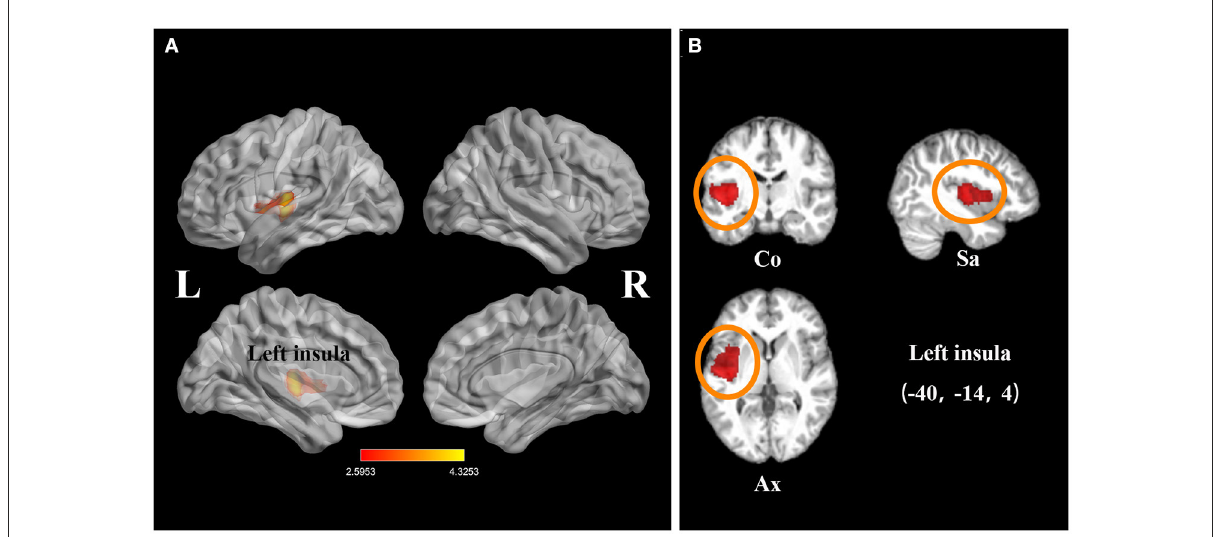
FIGURE4 Statistical parametric maps showing the decreased gray matter volumes in patients with spinal cord injury (SCI; time since injury > 1 year) compared with those of healthy controls in the subgroup meta-analysis. (A) The overlay of statistical parametric maps showing the decreased gray matter volume in left insula in SCI patients (time since injury > 1 year) compared with healthy controls. (B) The illustration of the sagittal, coronal, and axial planes of the decreased gray matter volume in left insula in SCI patients (time since injury > 1 year) compared with healthy controls. Color bar represents t -value; Co, Sa, and Ax represent coronal, sagittal, and axial planes, respectively. R, right; L left; SCI, spinal cord injury.